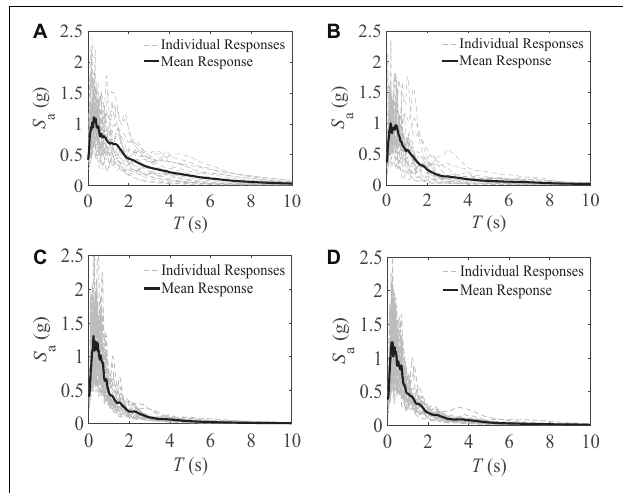
FIGURE 3 | 2.5%-damped pseudo-acceleration response spectra for the: (A,B) FD and PD components of the NF excitations; (C,D) NS and EW components of the FF